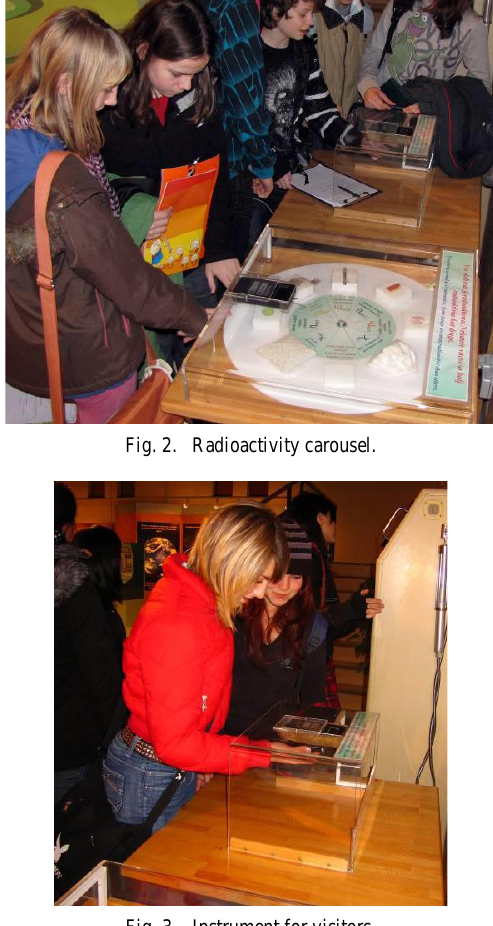
Fig. 3. Instrument for